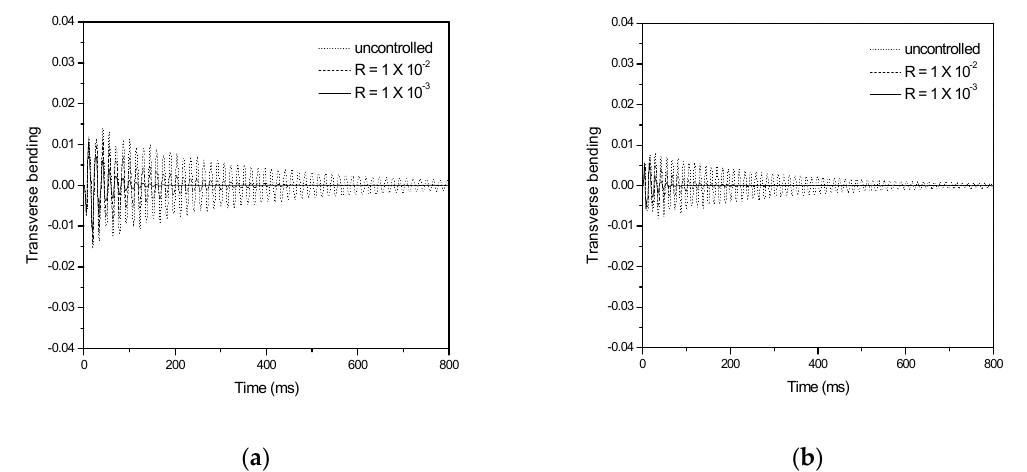
Figure 9. Transverse bending responses with two locations of stiffener using LQR control: ( a ) Stiffener Case 1; ( b ) Stiffener Case 2.